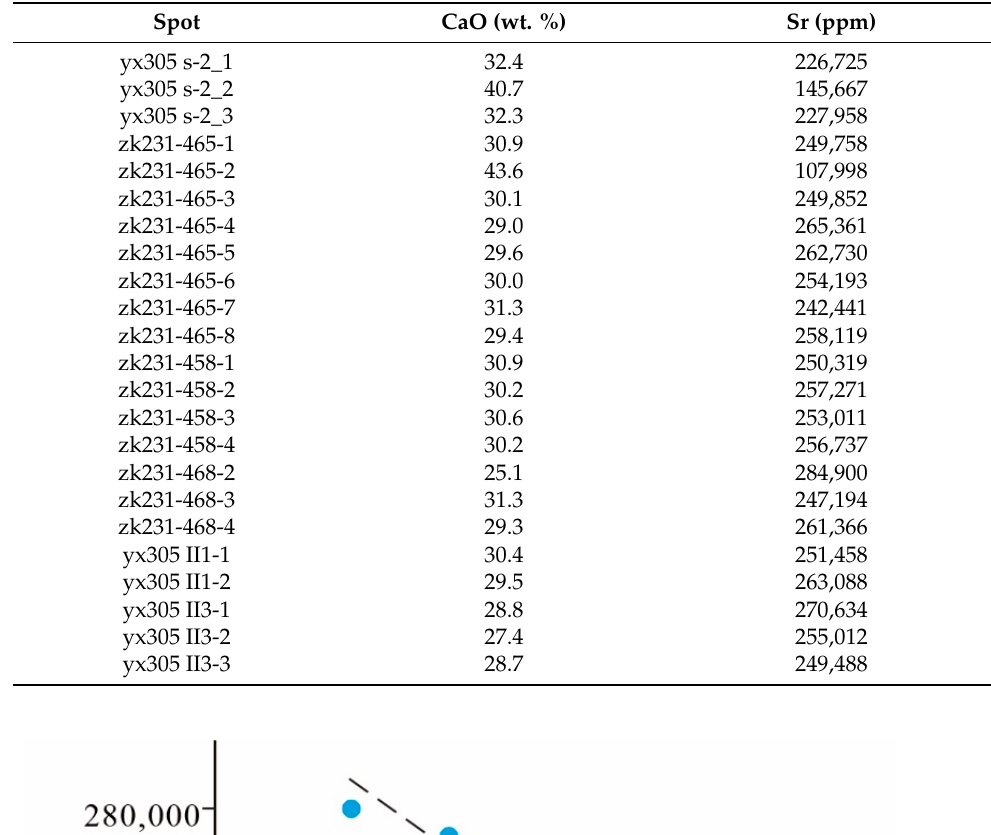
Table 4. Sr and CaO content of in situ analysis of celestine.